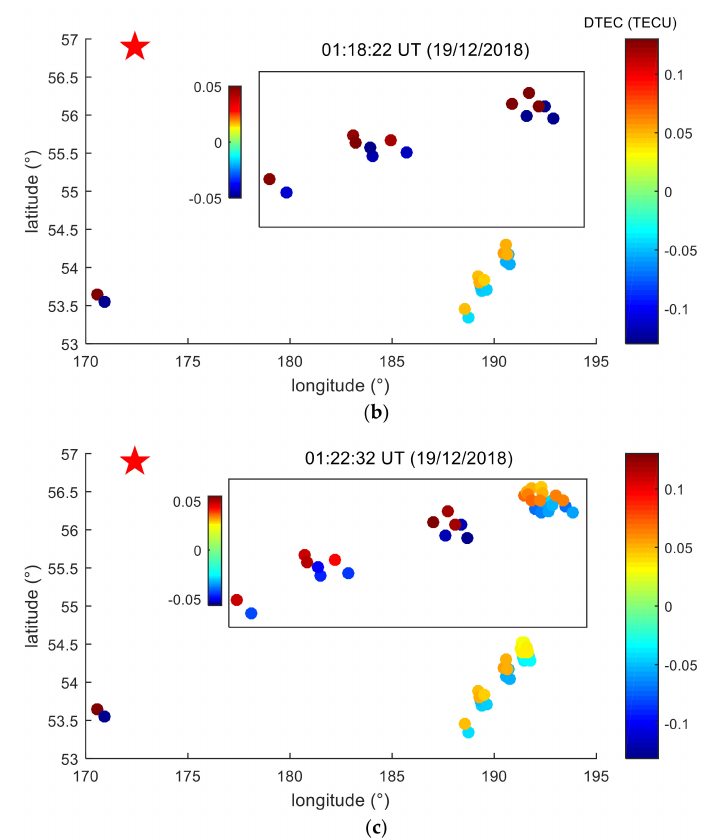
Figure 12. The spatial distribution of the maximum and minimum TEC of TID at di ff erent times. The five-pointed star is the location of the meteor explosion point. The rectangular frame is an enlarged view of the detected TID in 18 GPS stations. ( a ) is the spatial distribution of TID detected before 00:24:00 UT. ( b ) is the spatial distribution of TID detected before 01:18:22 UT. ( c ) is the spatial distribution of TID detected before 01:22:32